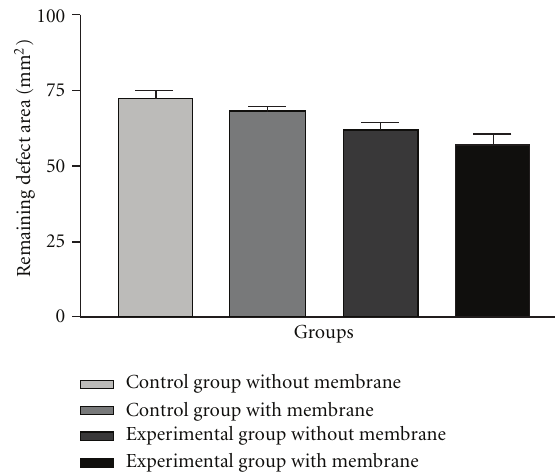
Figure 8: Tomographic analysis of the remaining bone defect area (in mm 2